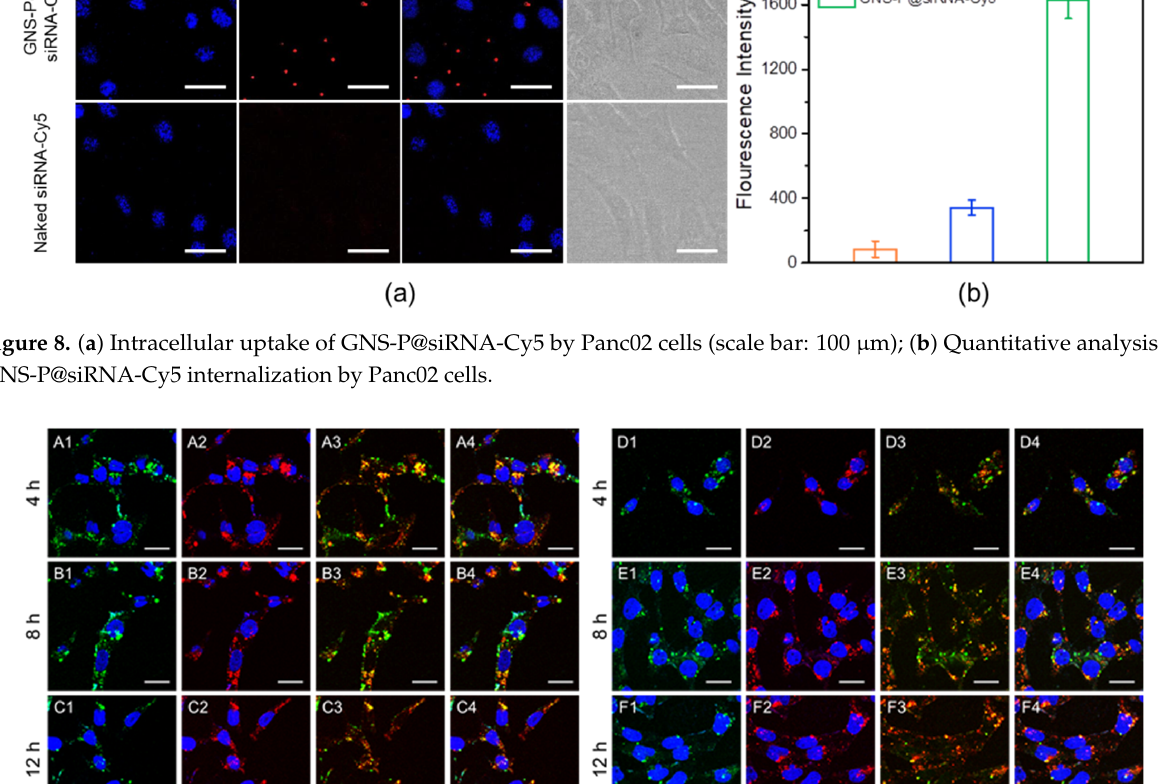
Figure 8. ( a ) Intracellular uptake of GNS-P@siRNA-Cy5 by Panc02 cells (scale bar: 100 μm); ( b ) Quantitative analysis of GNS-P@siRNA-Cy5 internalization by Panc02 cells.